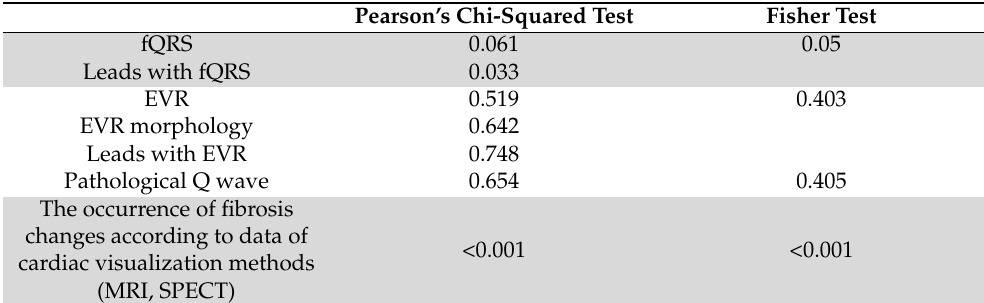
Table 3. Interrelation between studied ECG signs and mildly reduced ejection fraction of the left ventricular (40–49%).